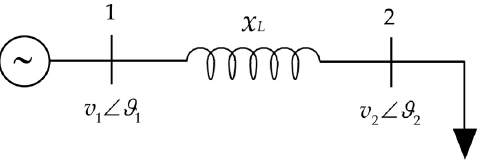
Figure 2. One machine, two-bus, one load system. Assumed as a reference the phasor